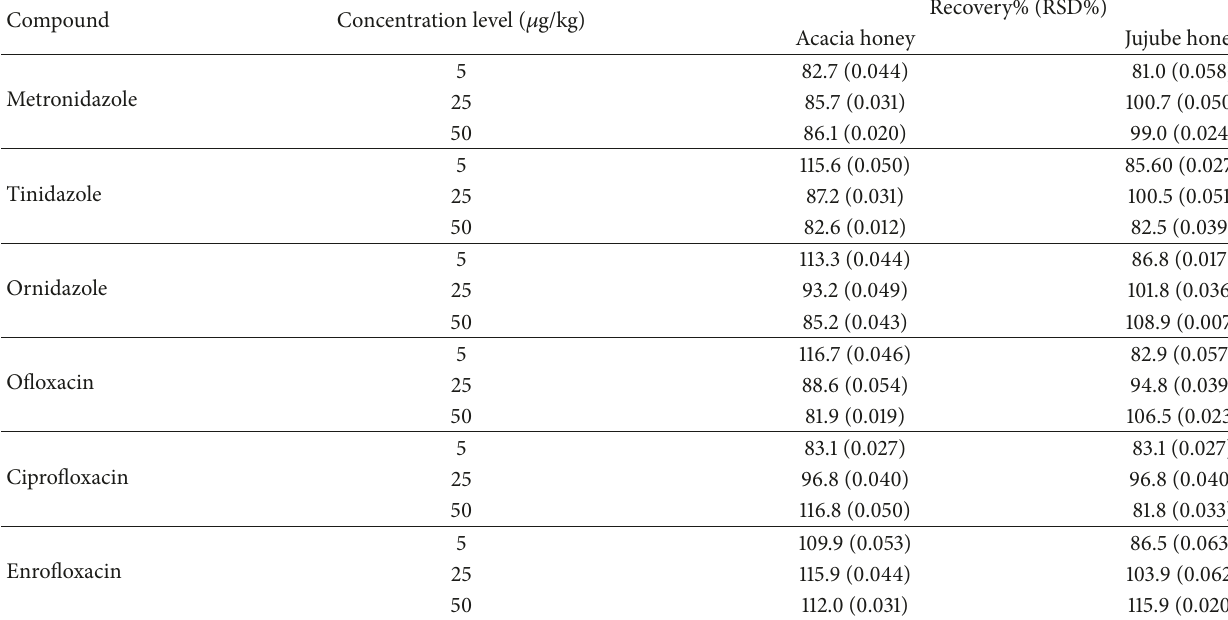
Table 5: Recovery rates and RSDs of target compounds from honey samples using by